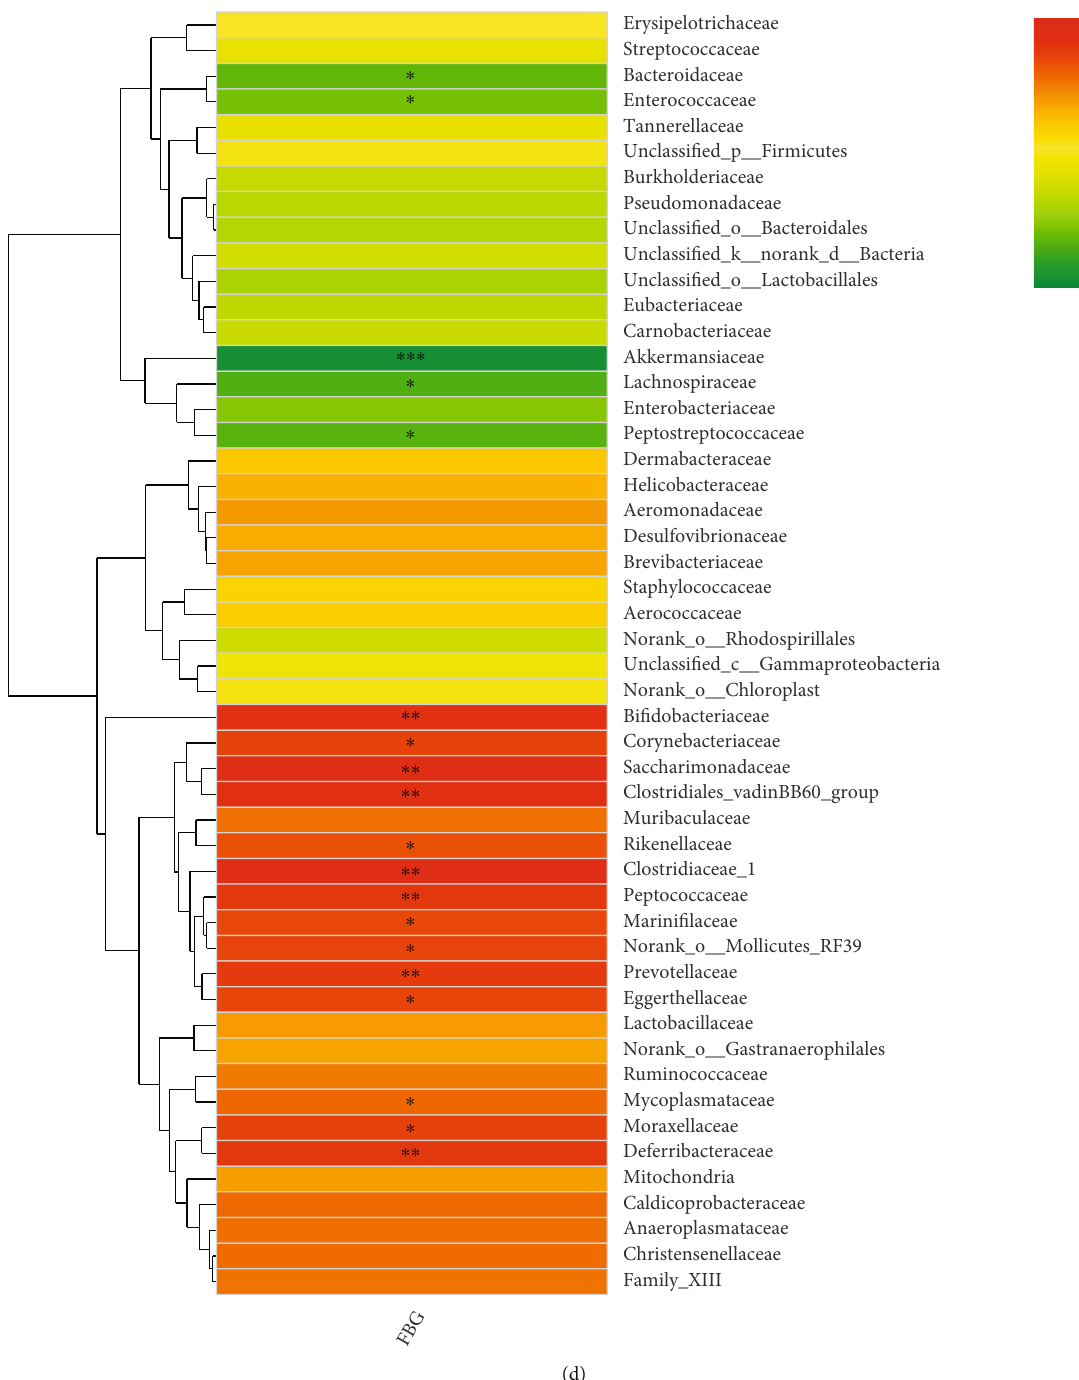
Figure 4: Signi fi cantly di ff erent between DC and SL groups of gut microbial community at the (a) family level, (b) genus level, and (c) OTU level. ∗ P < 0 : 05 and ∗∗ P < 0 : 01 , compared with the DC group. (d) Heatmap analysis indicating Spearman correlation between gut microbiota community and FBG on the family level, correlation R values, and P values were obtained by calculation; ∗ P < 0 : 05 and ∗∗ P < 0 : 01 ; R values were shown in di ff erent colors in the